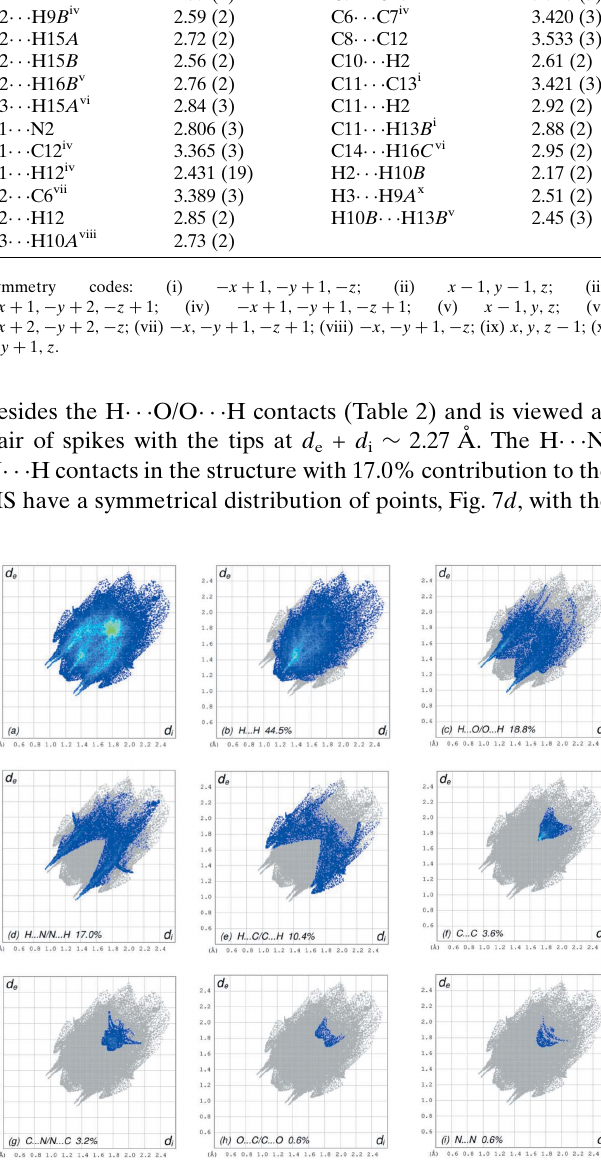
Figure 7 The full two-dimensional fingerprint plots for the title compound, showing ( a ) all interactions, and delineated into ( b ) H (cid:3)(cid:3)(cid:3) H, ( c ) H (cid:3)(cid:3)(cid:3) O/ O (cid:3)(cid:3)(cid:3) H, ( d ) H (cid:3)(cid:3)(cid:3) N/N (cid:3)(cid:3)(cid:3) H, ( e ) H (cid:3)(cid:3)(cid:3) C/C (cid:3)(cid:3)(cid:3) H, ( f ) C (cid:3)(cid:3)(cid:3) C, ( g ) C (cid:3)(cid:3)(cid:3) N/N (cid:3)(cid:3)(cid:3) C, ( h ) O (cid:3)(cid:3)(cid:3) C/C (cid:3)(cid:3)(cid:3) O and ( i ) N (cid:3)(cid:3)(cid:3) N interactions. The d i and d e values are the closest internal and external distances (in A˚ ) from given points on the Hirshfeld surface